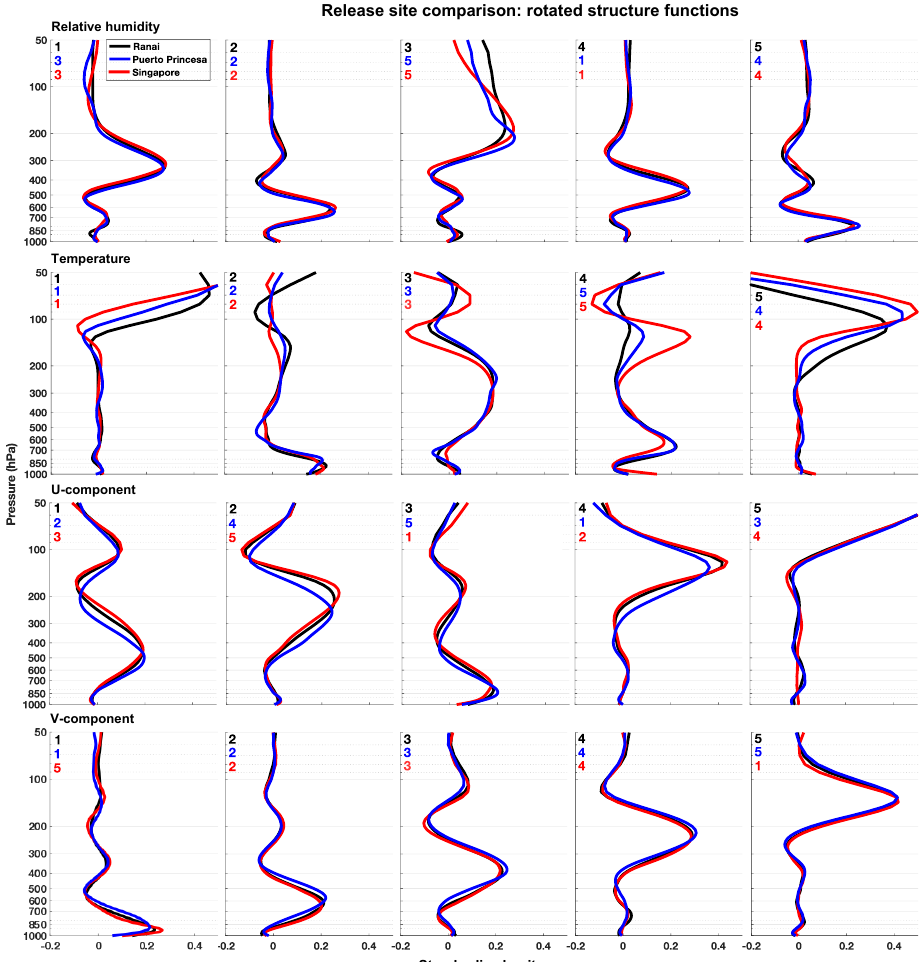
Figure 10. RCs for the three radiosonde sites in Ranai (black), Puerto Princesa (blue), and Singapore (red). The panel numbers represent the RC number for that specific signal and are color coded to match their respective upper-air sounding